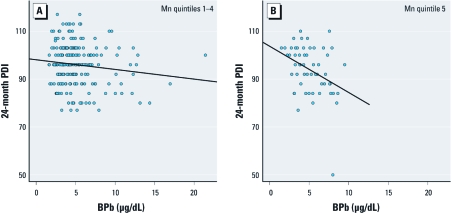
Scatterplots and regression lines of 12-month blood lead (BPb) on 24-month PDI among children with 12-month blood manganese (Mn) in quintiles 1–4 (A) and quintile 5 (B).